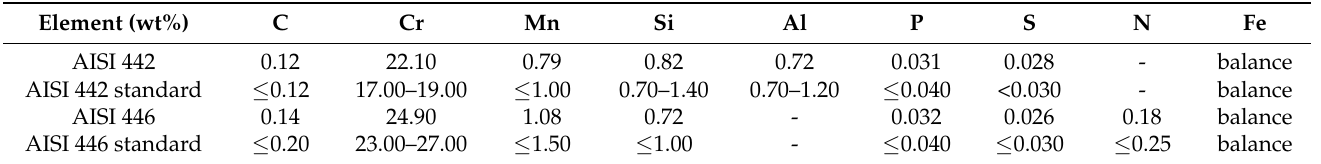
Table 1. Elemental composition of the ferritic stainless steel